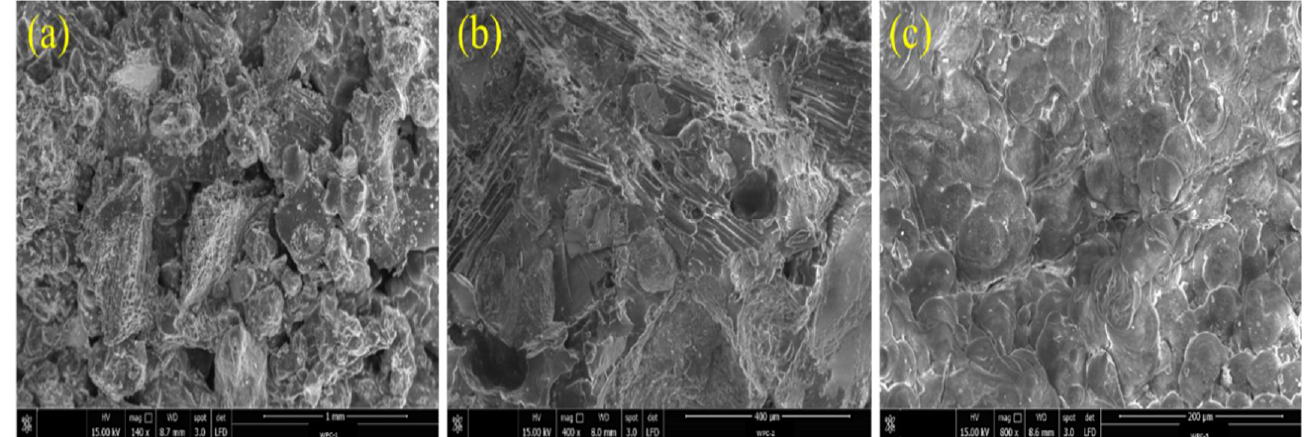
Figure 6. SEM micrographs of WPC samples: ( a ) WPC-1, ( b ) WPC-2, and ( c ) WPC-3.